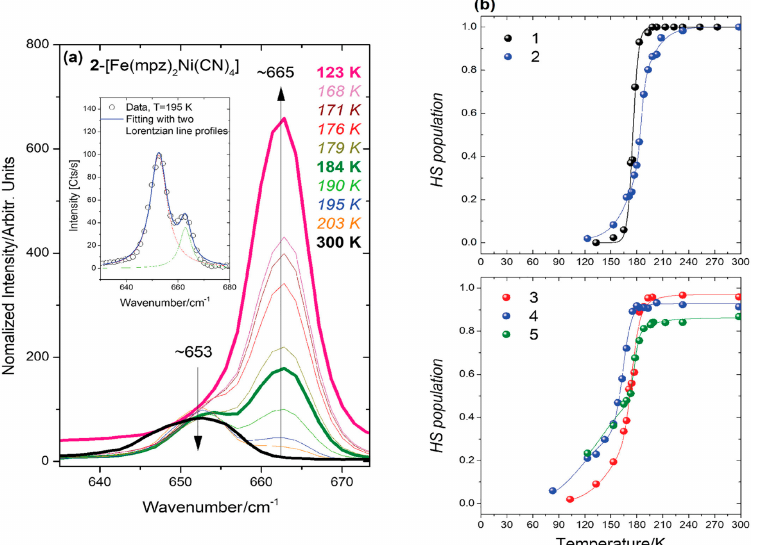
Figure 11. ( a ) Temperature-dependent Raman spectra of the [Fe(2-mpz) 2 Ni(CN) 4 ] ( 15 ) coordination complex in the region of pyrazine ring in-plane bending mode (~660 cm − 1 ). The 653 cm − 1 and 665 cm − 1 bands correspond to the HS and LS modes, respectively (the inset depicts the Lorentzian fitting used). ( b ) Calculated HS population as a function of temperature for the micro/nanosized systems (top/bottom) extracted by Raman spectroscopy. The figure is reprinted with permission from ref. [25], copyright 2020 John Wiley & Sons,